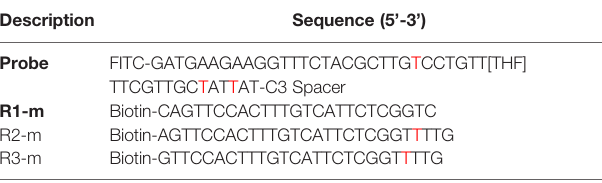
TABLE 3 | Design and modi fi cation of RPA-LFS probe and reverse primer sets. .